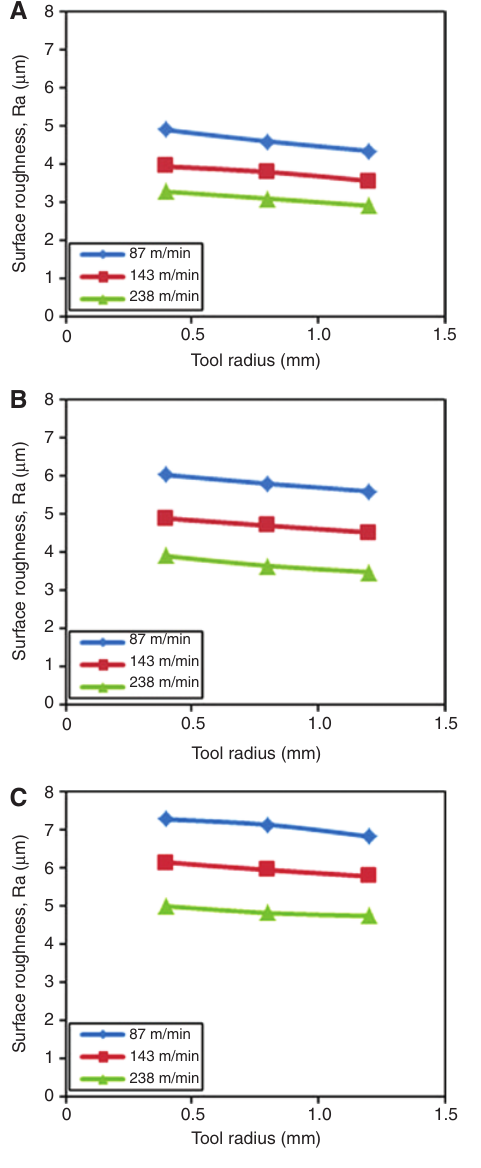
Figure 4 Effect of tool radius on surface roughness for various feed rates: (A) 0.052 mm/rev, (B) 0.104 mm/rev, and (C) 0.156 mm/rev.